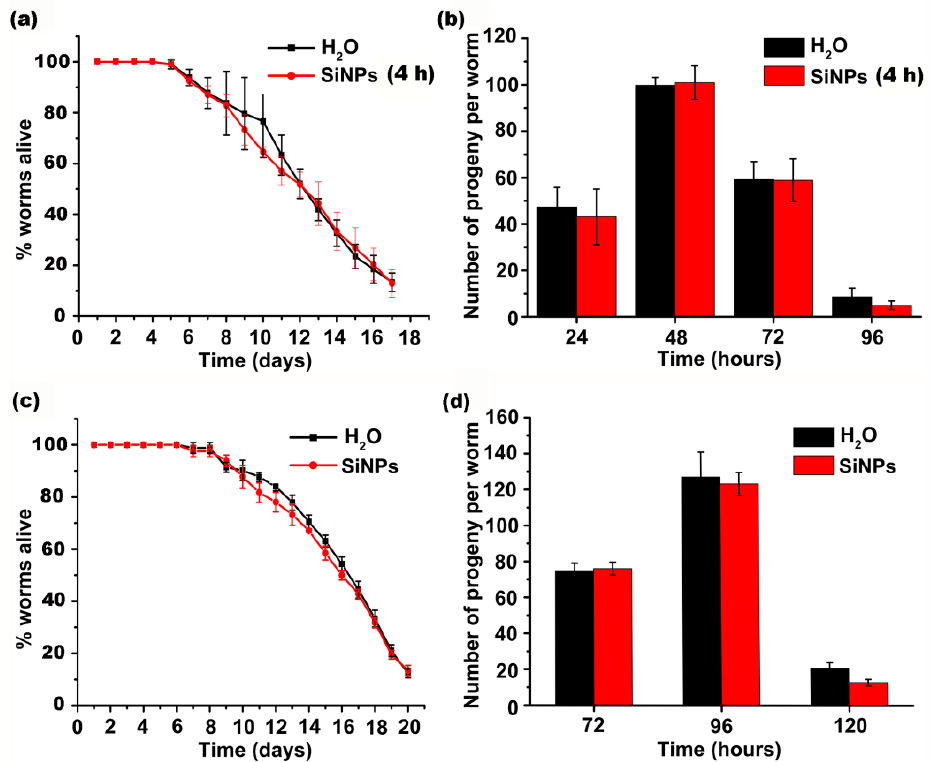
Figure 3. Short-term and long-term effects of SiNPs on the lifespan and reproduction of C. elegans . The survival curves ( a ) and the number of laid eggs ( b ) of the C. elegans administrated with H 2 O or SiNPs for 4 h from L4 larval stage. The survival curves ( c ) and the number of laid eggs ( d ) of the C. elegans continuously administrated with H 2 O or SiNPs from L1 stage until H 2 O control group reached young adult stage. All experiments were repeated independently three times (three biological replicates, N ≥ 30/condition for data in ( a , c ), N ≥ 10/condition for data in ( b , d ). Error bars represent mean ± SEM. The statistical analysis indicated that there were no significant differences in the lifespan and brood sizes between the H 2 O-treated control group and SiNP-treated group ( p > 0.05).